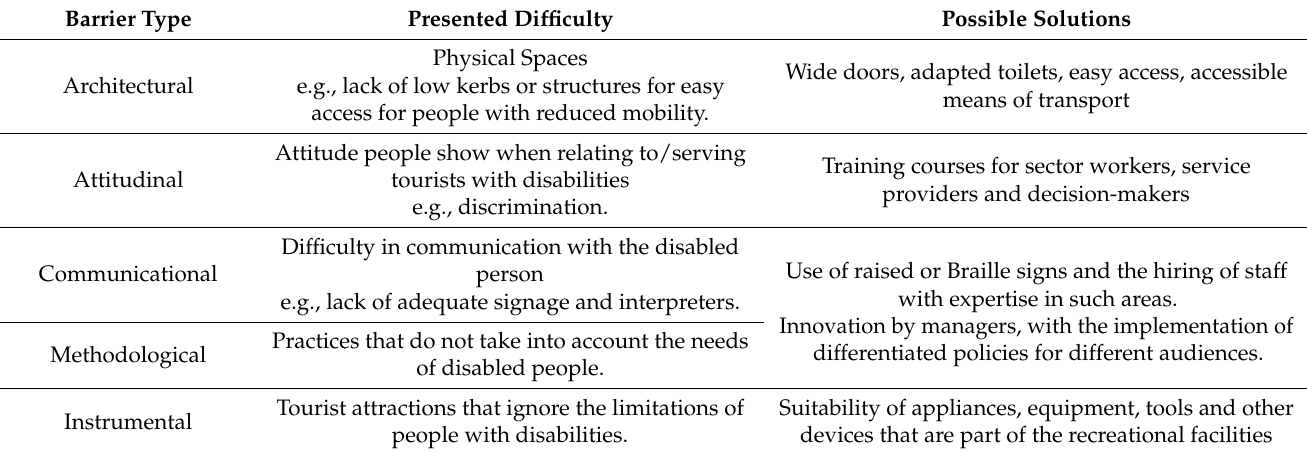
Table 1. Barriers that hinder accessibility for people with reduced mobility. Source: Adapted from Sassaki